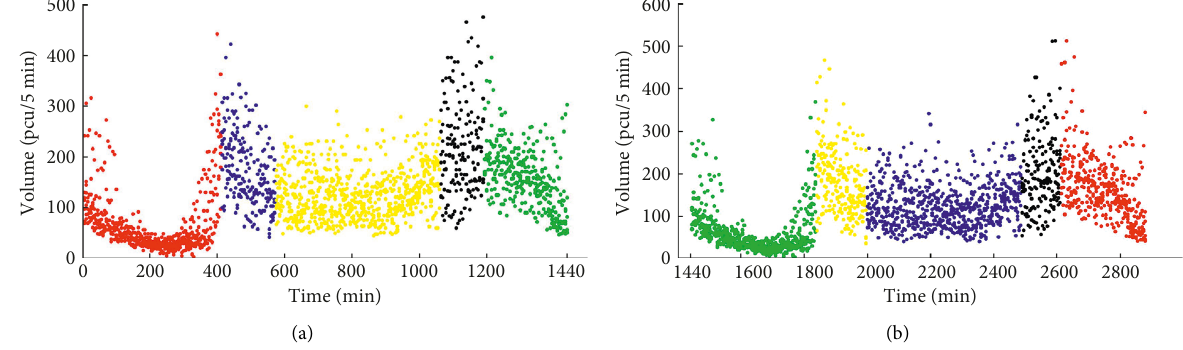
Figure 7: Temporal characteristics of the traffic flow clustering results. Table 7: The 48-hour time-space division results of Zhongshan Road.